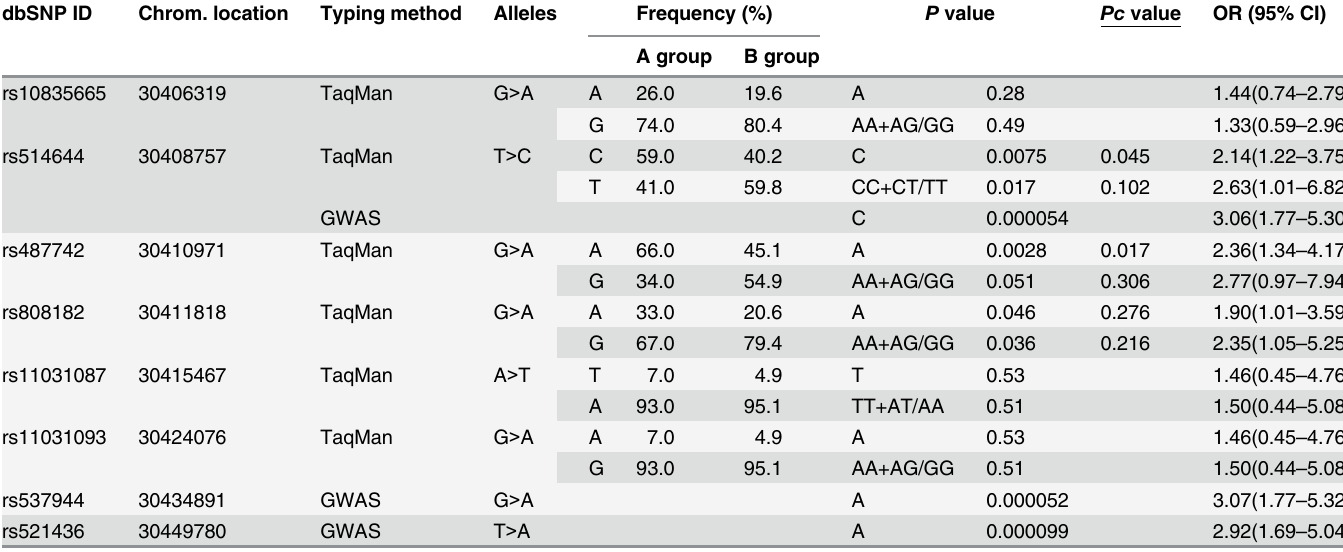
Table 6. Association analysis of single nucleotide polymorphisms in the MPPED2 gene. dbSNP ID Chrom.